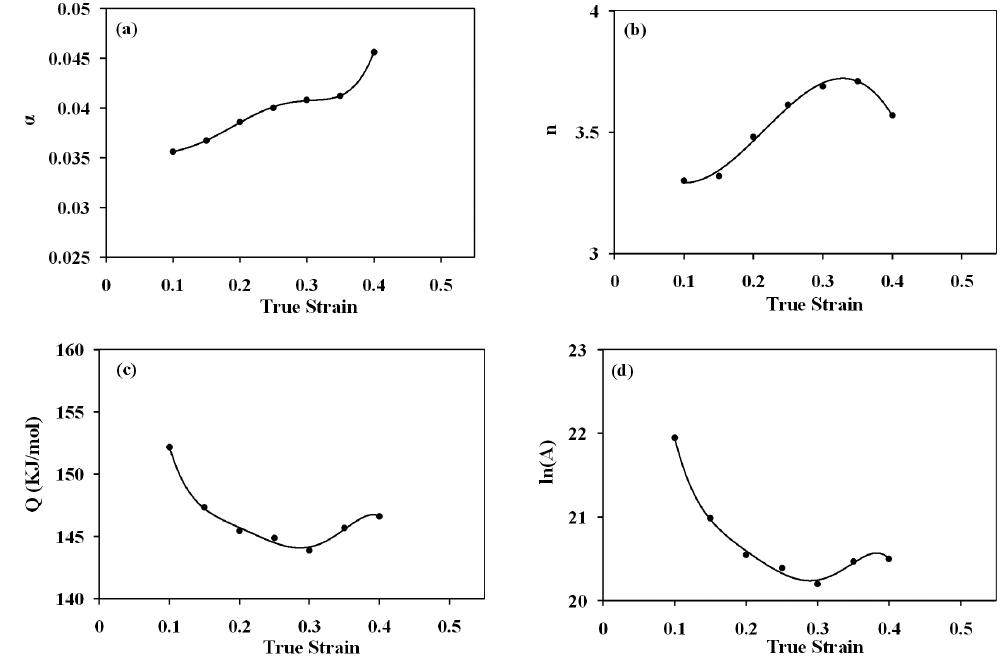
Figure 5. Variation of (a) α (b) n (c) Q and (d) ln A with true strain for rolled microstructure.